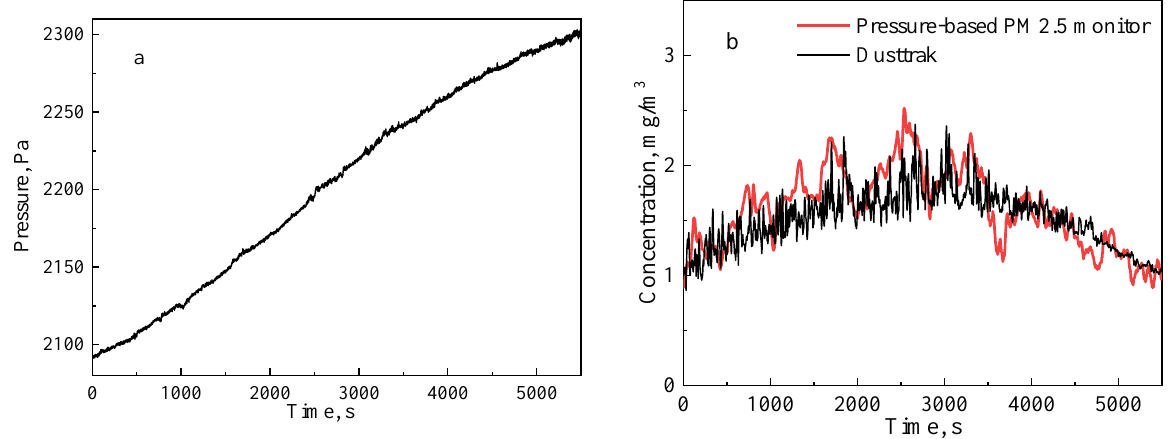
Figure 7. ( a ) Variation of pressure with time in the cylindrical chamber with gradually decreasing PM 2.5 concentration. ( b ) Variation of ΔP/Δt ( Δt = 60 s) with time. ( c ) Comparison between PM 2.5 concentration calibrated by the pressure data and recorded by Dusttrak. ( d ) Regression plots for PM 2.5 mass concentration: pressure-based PM monitor vs. Dusttrak.